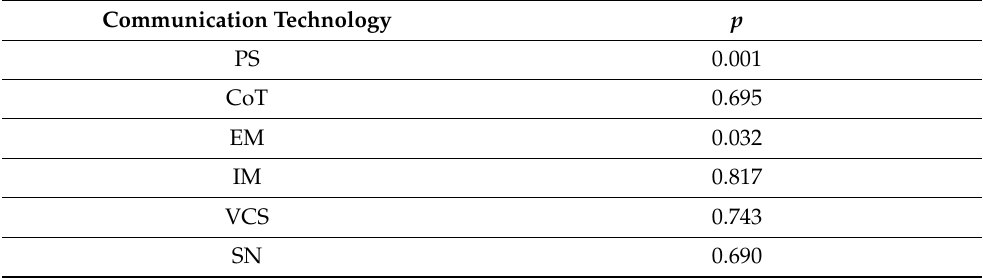
Table 27. Results of statistical inference t-test to verify the independence of the responses of students and teachers to question 12 on the satisfaction on the use of communication technologies ( p ≤